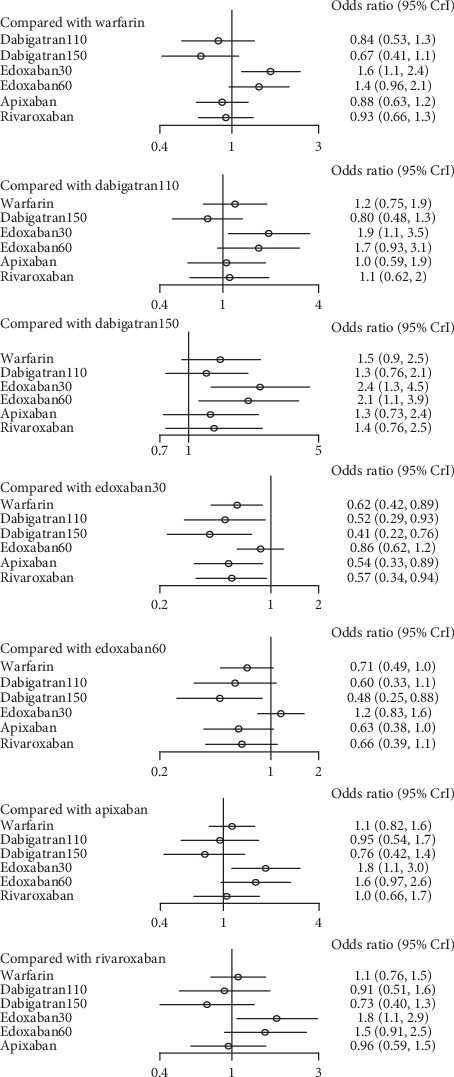
Ranking plots for the efficacy of the comparison among different treatments of patients with normal renal function.